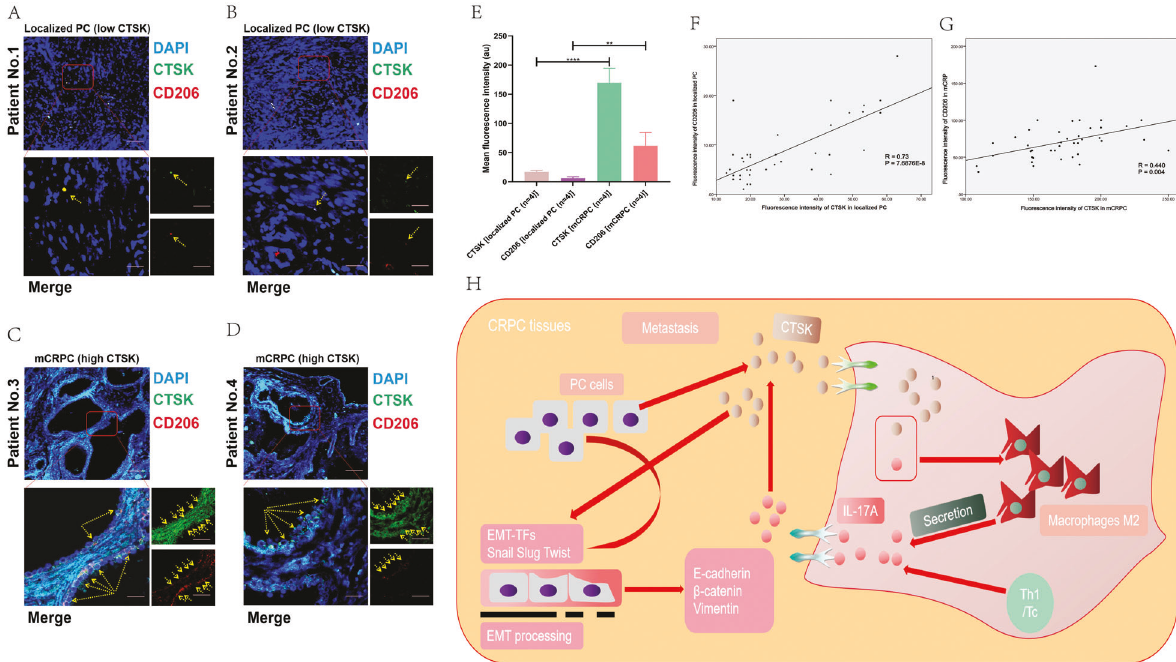
Fig. 7 High expression of CTSK is related to high enrichment of M2 macrophages of tumor-associated in CRPC. A – D IF assay analysis of the correlation between CD206 and CTSK in prostate cancer tissues. E Quanti fi cation of immuno fl uorescence by confocal microscopy. Histograms show quanti fi cation of 10 – 25 different images per condition. F Correlation curve of CTSK and CD206 expression in localized PC tissues by quanti fi cation of immuno fl uorescence, eight sites are selected for each tissue. G Correlation curve of CTSK and CD206 expression in CRPC tissues by quanti fi cation of immuno fl uorescence, eight sites are selected for each tissue. H The pro fi le mechanism of the regulation and mechanism of IL-17A/CTSK-mediated CRPC